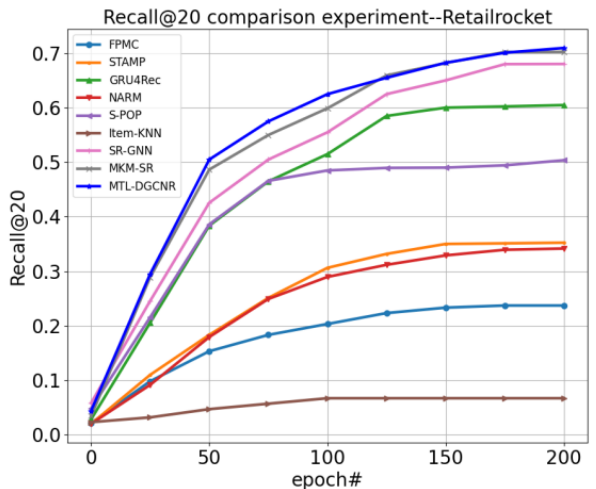
Figure 6. Recall@ 20 change graph on JData.